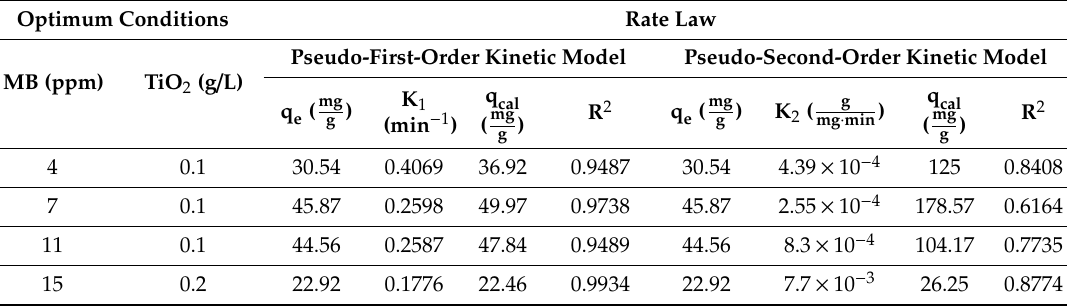
Figure 16. Kinetic data fitting: ( a ) pseudo-first-order kinetic model fitting; ( b ) pseudo-second-order kinetic model fitting. Table 5. Kinetics parameters for adsorption of MB on TiO 2 at the optimum Table 4. Optimum conditions for PMR performance